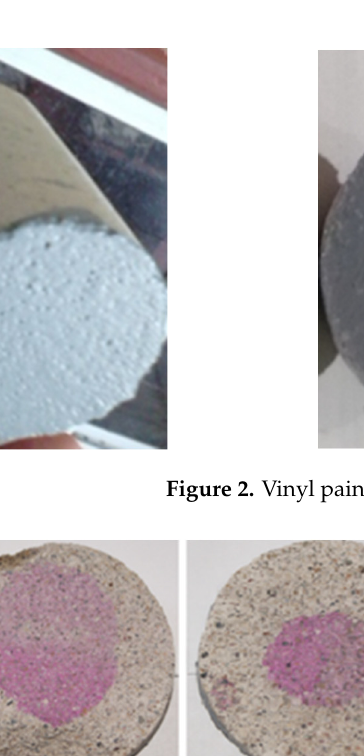
Figure 3. Carbonation monitoring by using phenolphthalein and thymolphthaleine.